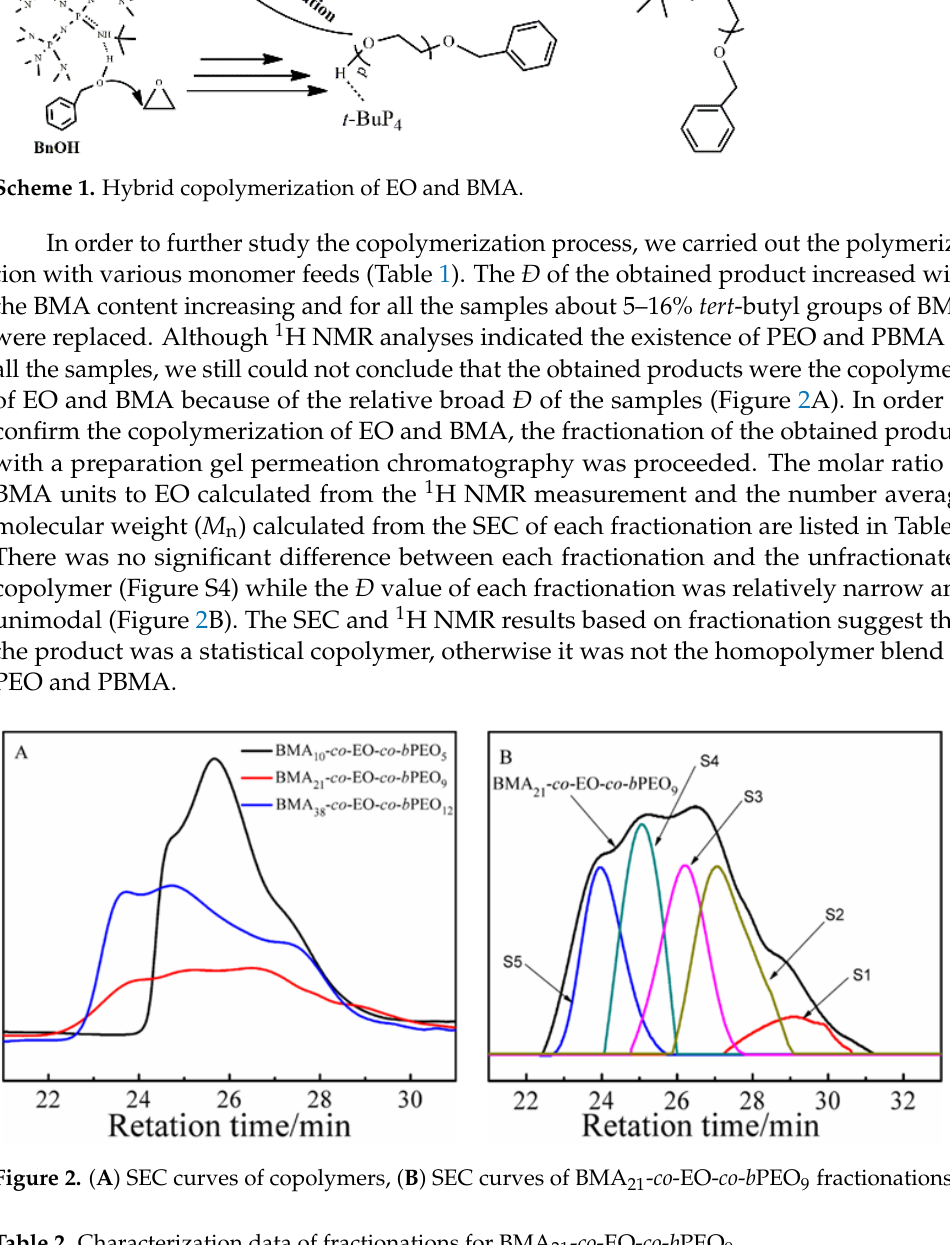
21 - co -EO- co - b PEO 9 fractionations.